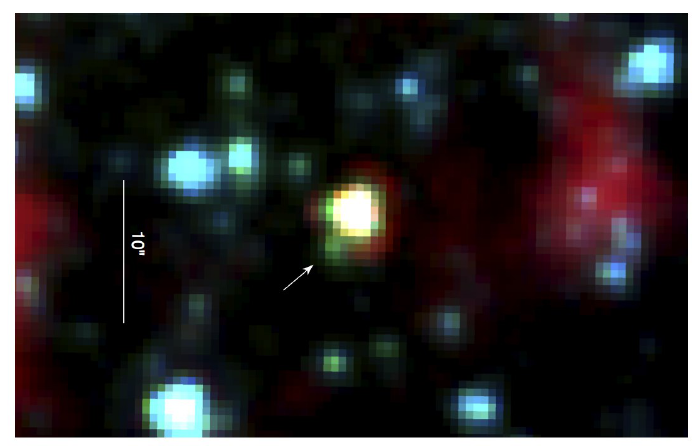
Fig. 6. A color composite of the 3.6 (blue), 4.5 (green) and 8.0 (red) µ m images from Spitzer/IRAC of V2282 Sgr. A faint extension of the source in the SE direction (arrow) is evident mainly in the 4.5 µ m filter, where a major contribution from H 2 emission is expected. with time scales of about 10